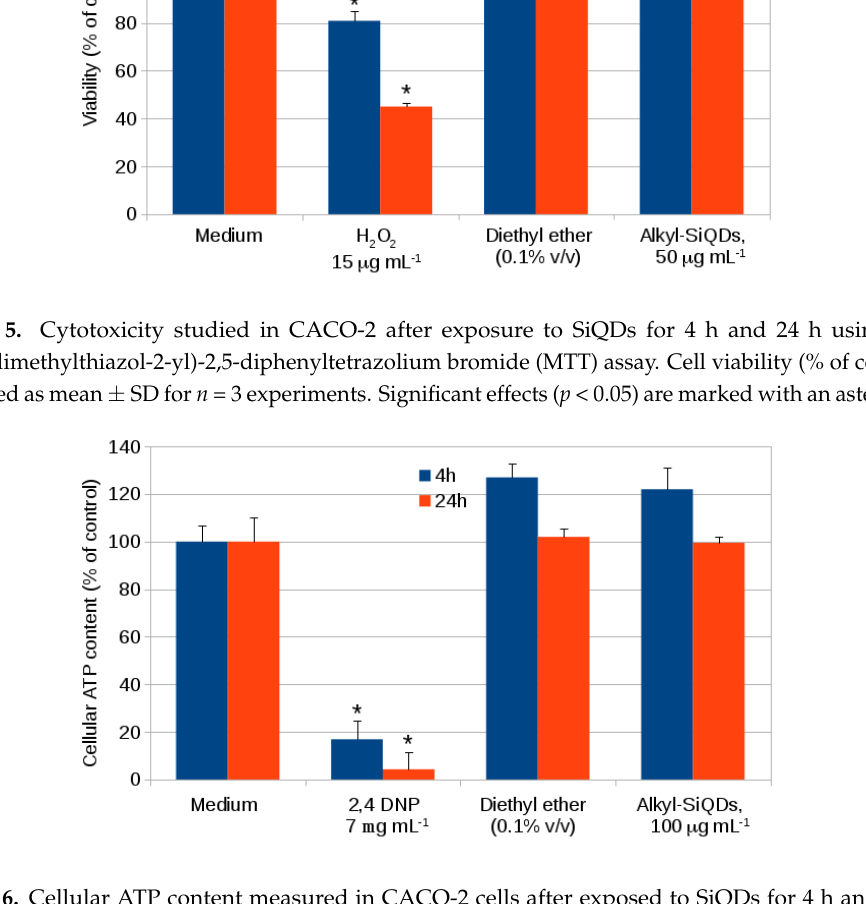
Figure 6. Cellular ATP content measured in CACO-2 cells after exposed to SiQDs for 4 h and 24 h using the fluorescent ATP somatic cell (FLASC) assay (Sigma-Aldrich). The ATP content (% of control) represent with means ± SD for n = 3 experiments. Significant effects ( p < 0.05) are marked with an asterisk